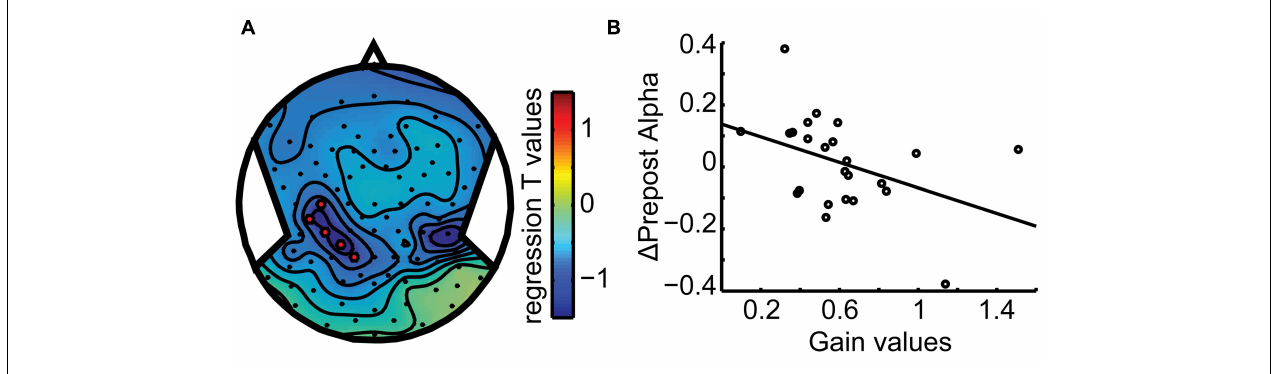
FIGURE 7 | Behavioral Correlation. (A) Scalp topography plot of the regression t -value distribution for the gain-alpha pre–post analysis. A left parieto-temporal cluster (C3, CP6, CP3, P1, CCP5h, and CPP3h) shows a significant negative correlation (B) with gain values ( r = − 0.41). Data points mark subject averages of gain and pre–post alpha modulation over the three displacements. This indicates that higher performance (gain) goes along with a larger modulation of alpha band activity, specifically more alpha reduction after